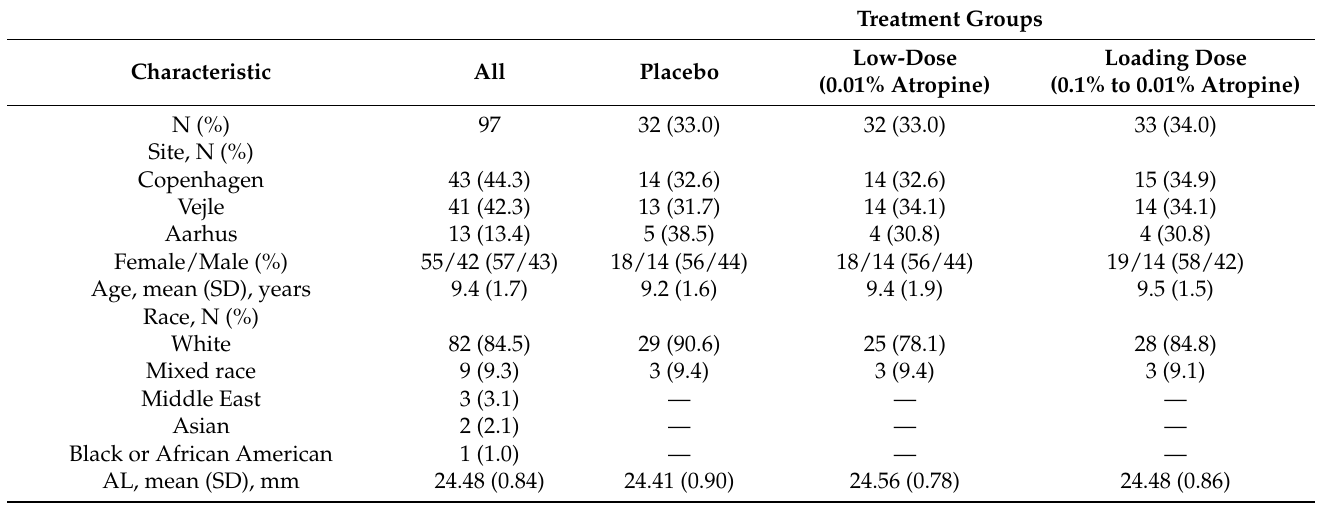
Table 1. Baseline characteristics of randomized